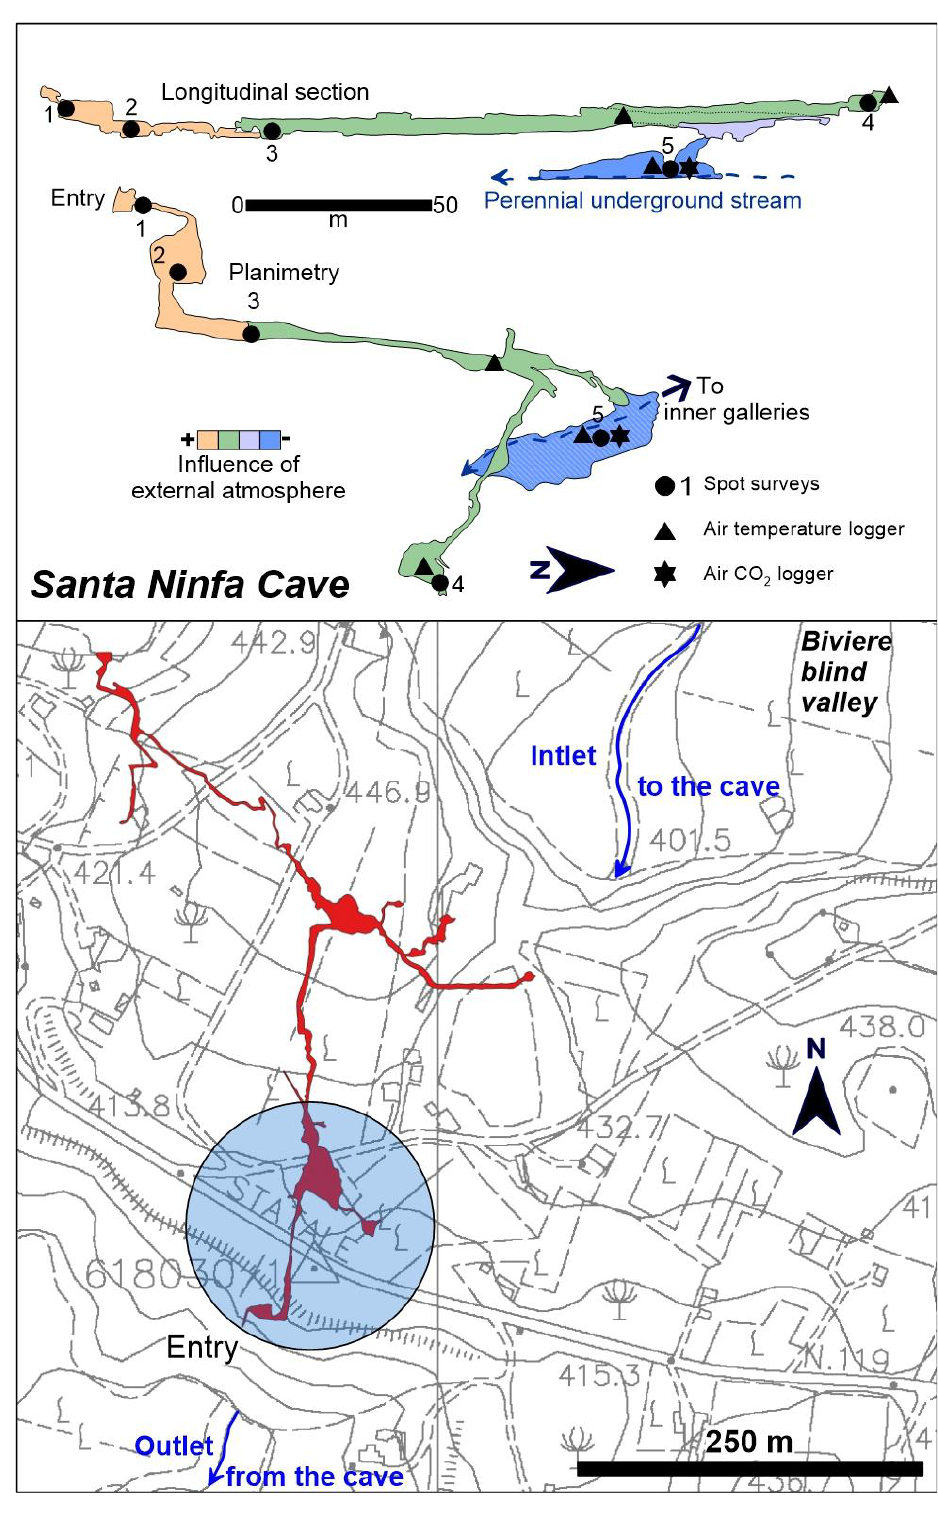
Figure 3. At the top, planimetry and longitudinal section of the Santa Ninfa cave, with location of the points of measure (spot and quasi-real time); volumes with different degree of connection with the epigeal atmosphere are also indicated. At the bottom, surface projection of the area occupied by the cave (the blue circle indicates the portion of the cave involved in the monitoring program).